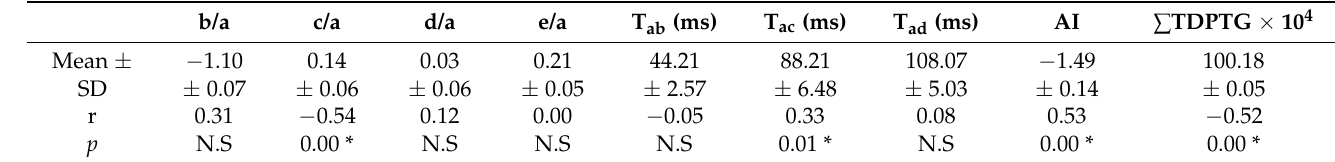
Table 2. Results of the correlated variables with age.